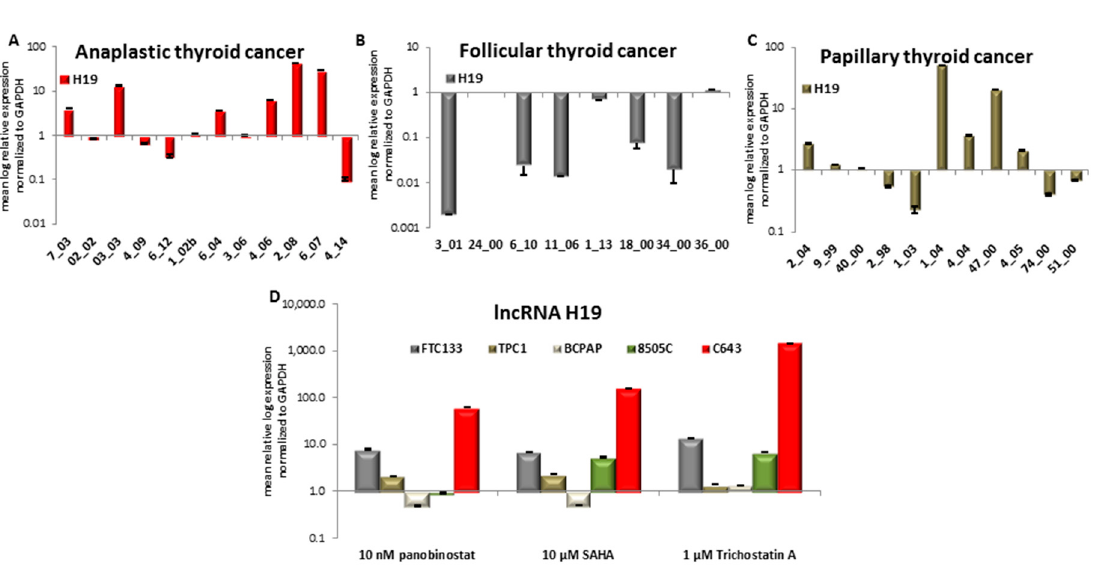
Figure 8. Expression of lncRNA H19 in ATC, FTC, PTC, and thyroid cancer cells that were treated with deacetylase inhibitors. RT-qPCR analysis of TTF1 transcript level in ATC ( A ), FTC ( B ), PTC ( C ) and FTC133, TPC1, BCPAP, 8505C and C643 cells ( D ) after 48 h of treatment with 10 nM panobinostat, 10 µ M SAHA and 1 µ M Trichostatin A. mRNA expression was normalized to GAPDH. Results are expressed relative to untreated controls set at 1.0. Shown are means ± SEM of three independent experiments performed in triplicates.